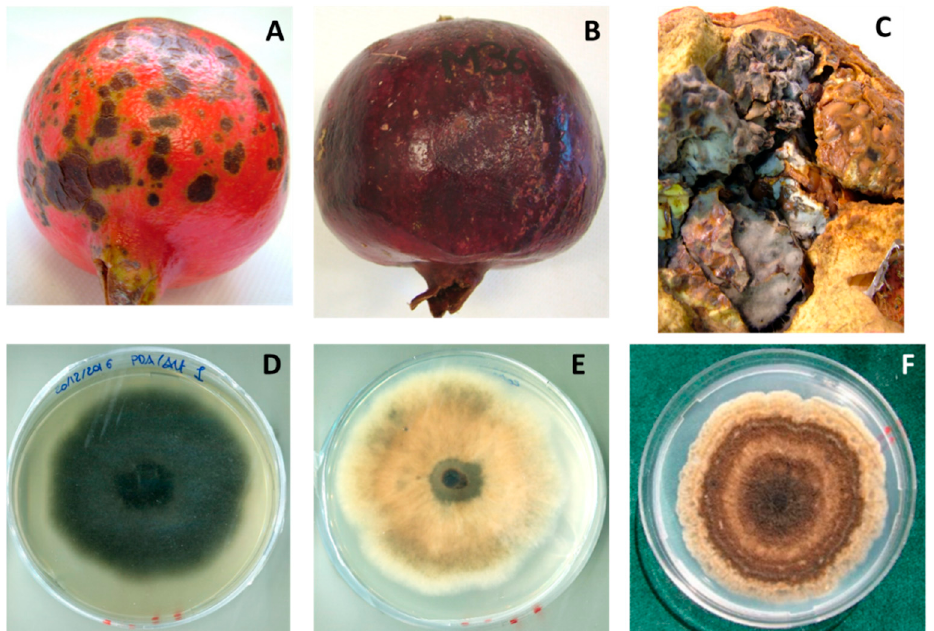
Figure 6. ( A ) Black spot and ( B ) black heart caused by Alternaria spp. ( C ) Close ‐ up on heart rot showing mycelium growth. Colonies on PDA of Alternaria alternata : ( D ) dark and ( E ) whitish strains. ( F ) Colony of Alternaria arborescens on PDA.